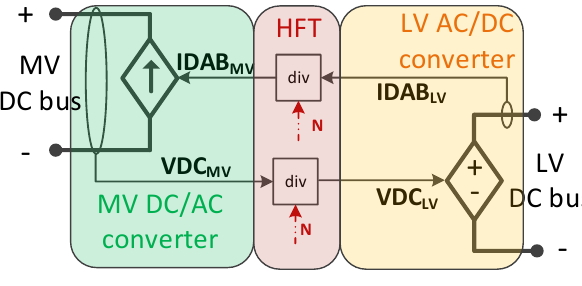
Figure 4. DC-DC converter stage model.